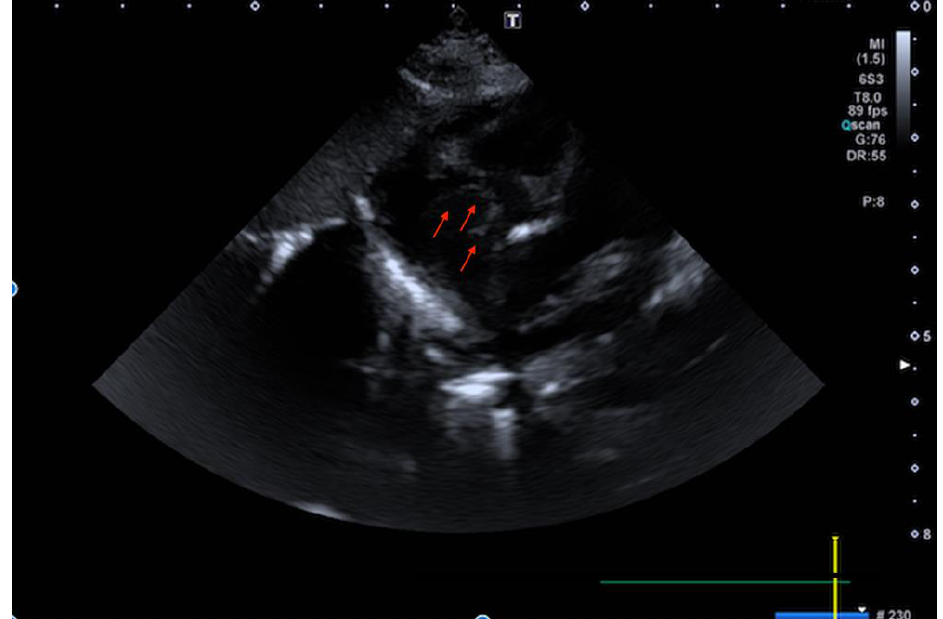
Figure 1. Transthoracic echocardiogram (TTE) (subcostal view) shows the membrane arising from the inferior vena cava (IVC) and reaching the interatrial septum.